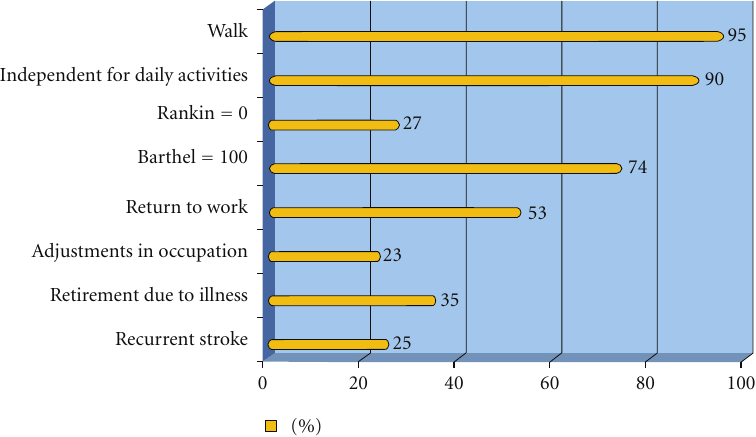
Figure 2: Functional outcome after long-term followup of young adults with ischemic stroke (number of patients: 240; mean followup